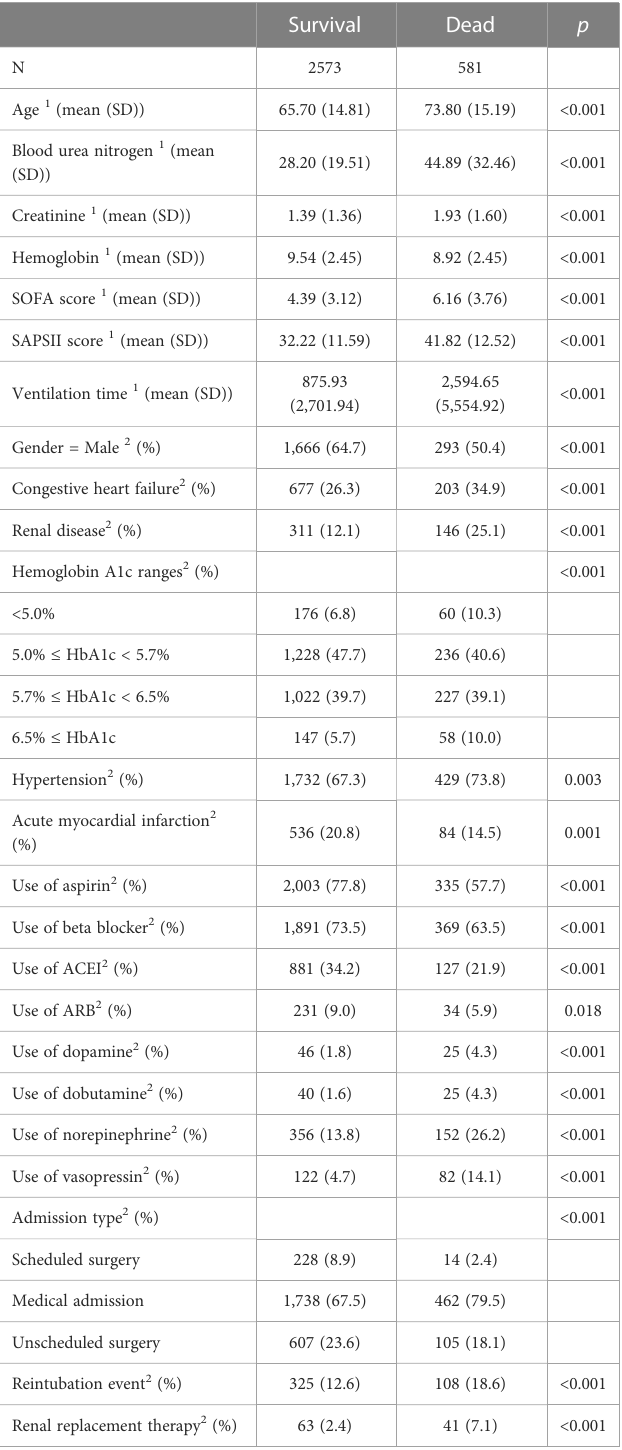
TABLE 1 Characteristics of the study population ( N = 3,154).